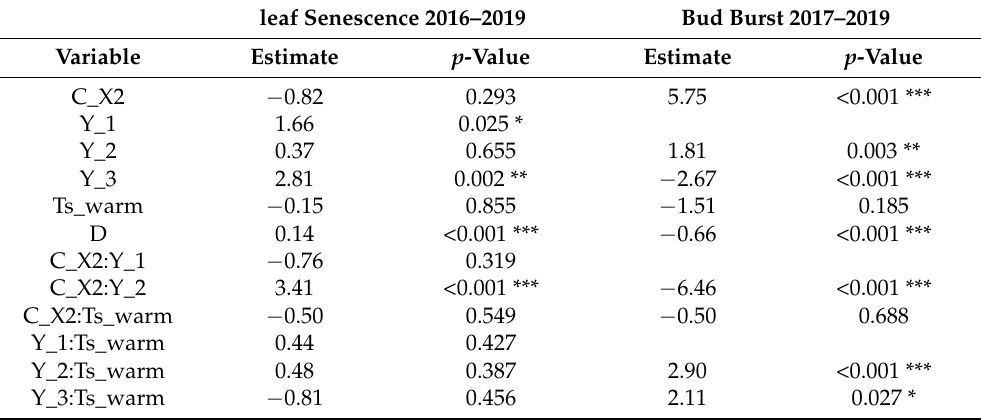
Table 2. Estimates and p -values for the modeled leaf senescence (2016–2019) and bud burst (2017–2019). The first controlled cross, X1 (C_X1), is the standard to which the second cross is compared (C_X2). The “cold” condition of the seed maturation temperature is the standard condition to which the “warm” (Ts_warm) are compared. For leaf senescence, the year of germination of the seedlings Y_0 (2016 for cross X1 and 2017 for cross X2) is the standard to which the years after germination are compared (Y_1, Y_2, and Y_3). For bud burst, the first year after germination of the seedlings Y_1 (2017 for cross X1 and 2018 for cross X2) is the standard to which the years after this year are compared (Y_2 and Y_3). D is the day of